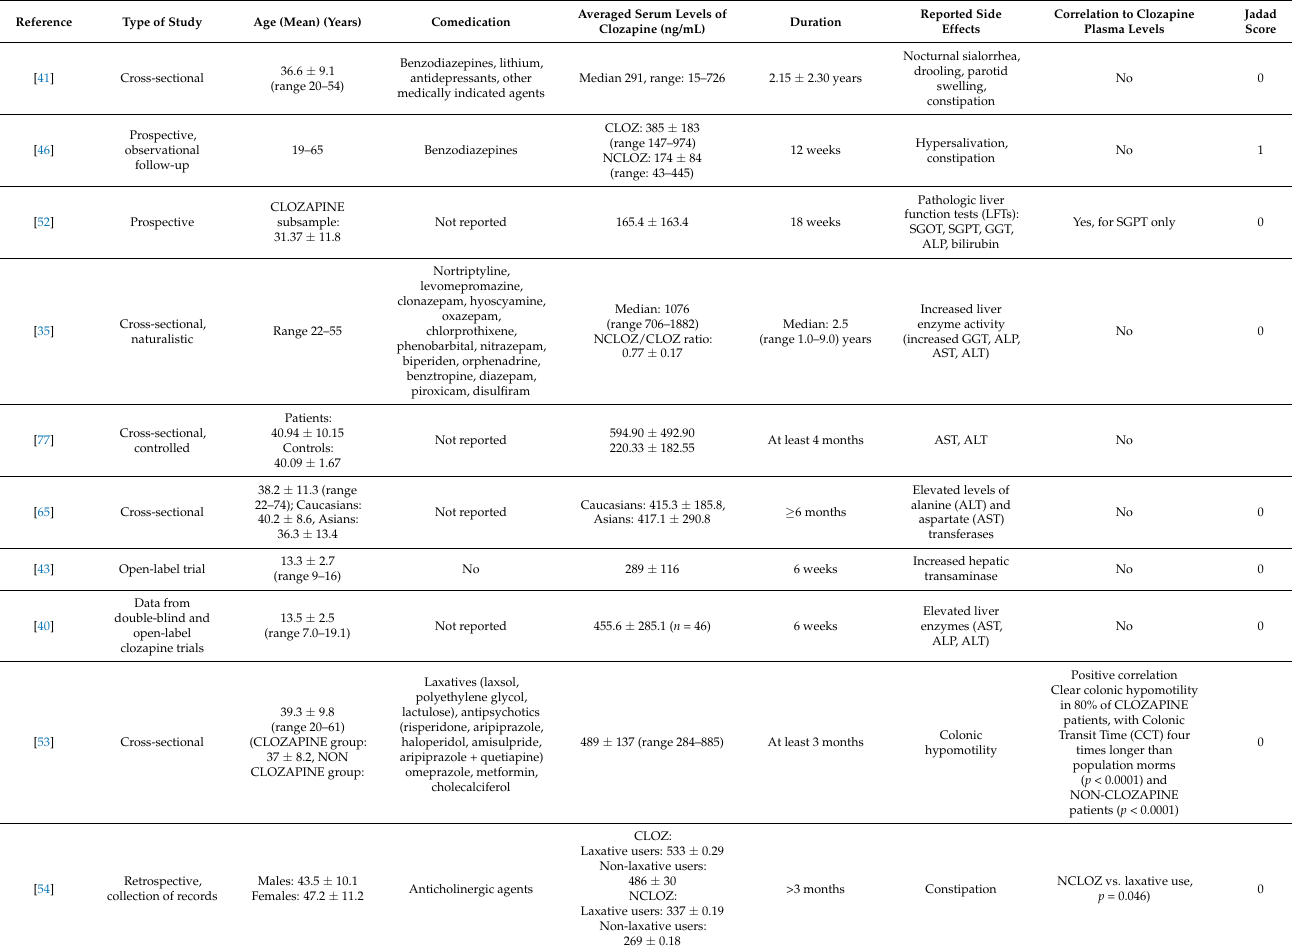
Table 6. Gastrointestinal adverse effects in relation to CLOZAPINE blood